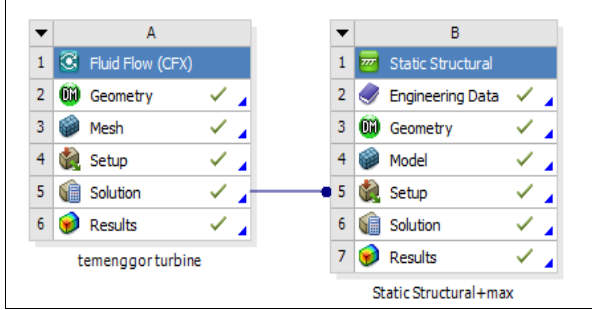
Figure 3. The connection between ANSYS-CFX solution and static structural setup.